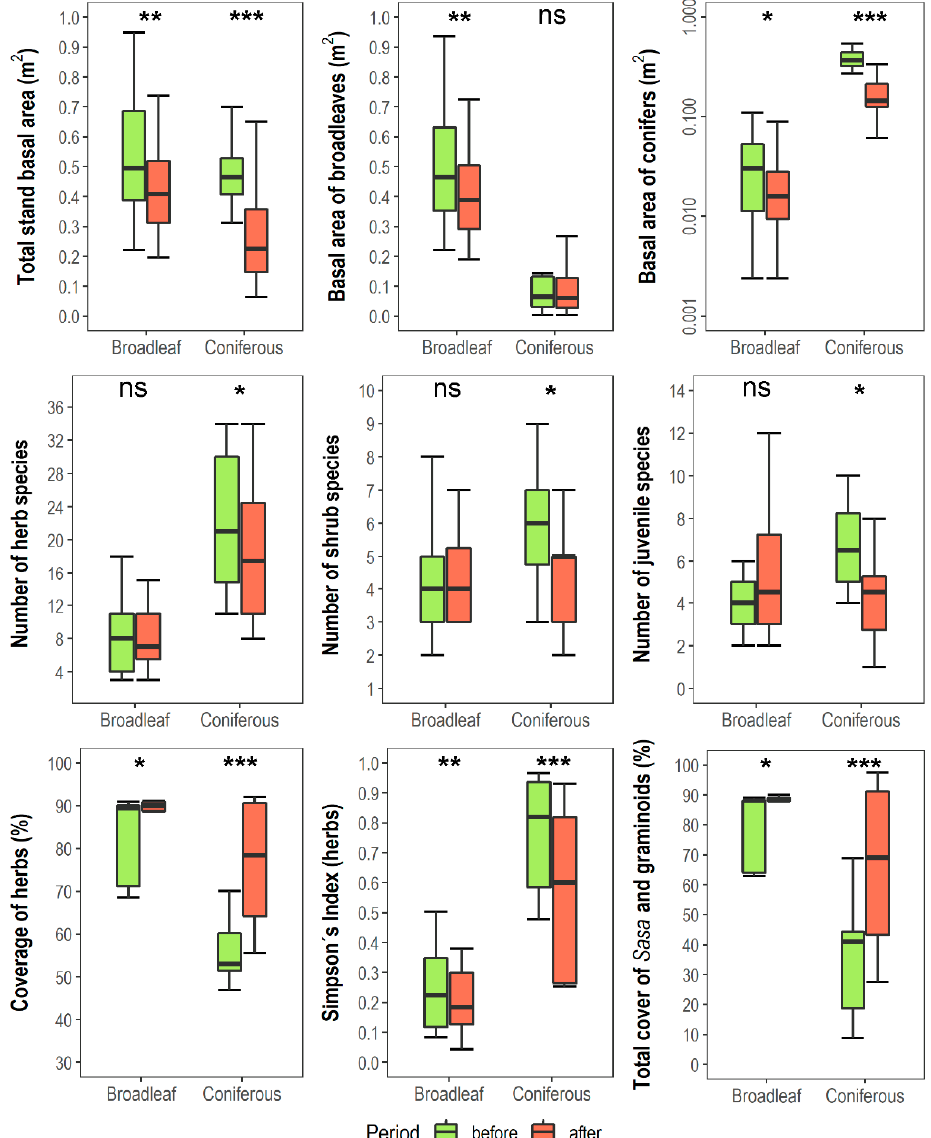
Figure 3. Differences in stand structure and vegetation diversity variables between pre-disturbance (before typhoon) and post-disturbance (after typhoon) broadleaf and coniferous forests. Data for BA values were sampled in 40 permanent plots, other data in 36 permanent plots (all but 1629–1631 m plots). The level of significance is indicated above the boxes: ns: non-significant; * p < 0.05; ** p < 0.01; *** p < 0.001. Boxes represent 25%–75% of values, black strips medians, whiskers 1.5 interquartile ranges. Note the logarithmic transformation of y -axis in the case of plotting the basal area of conifers due to the too low values of this variables in broadleaf forests.